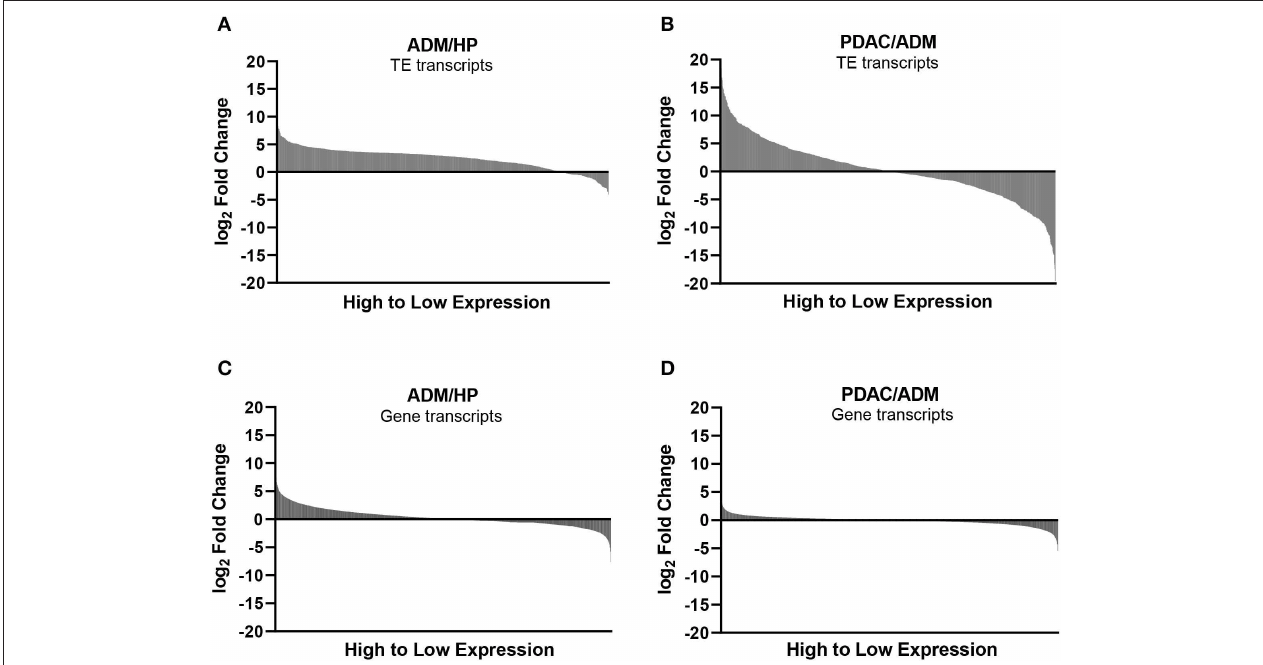
FIGURE 1 | Expression of transposable elements (TEs) and non-TE, gene-encoded transcripts during transition to malignancy. (A) Waterfall plots of TE expression, using RNA-seq, during the transition from healthy pancreas (HP) to acinar-to-ductal metaplasia (ADM) (pre-malignant) and (B) from ADM to pancreatic ductal adenocarcinoma (PDAC) (malignant). (C) Waterfall plots of non-TE, protein coding gene transcripts displayed in order from highest to lowest fold change for ADM/HP and (D) PDAC/ADM.